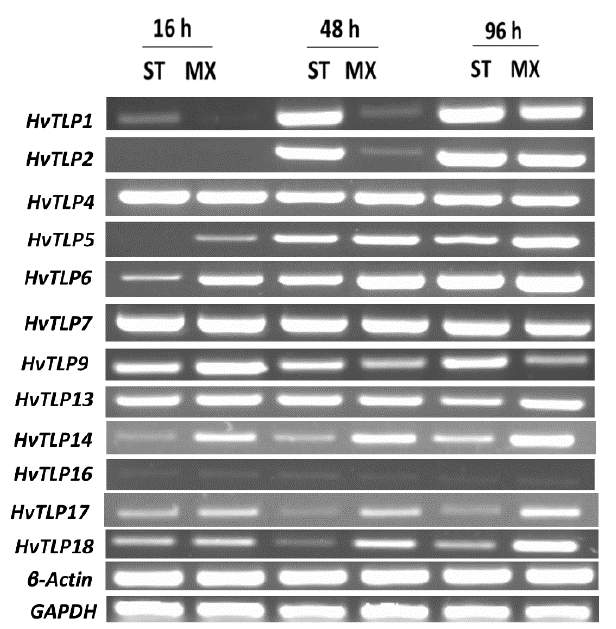
Figure 5. Transcript abundance of HvTLP genes at different stages of seed germination . Gel representation of the expression profiles of HvTLPs ( 1 , 2 , 4 , 5 , 6 , 7 , 9 , 13 , 14 , 16 , 17 and 18 ) and the housekeeping genes β -actin and GAPDH at 16 h, 48 h and 96 h of germination in malting (MX = Morex) and feed (ST = Steptoe) varieties of barley using RT-PCR. 1.2% agarose gel was used to resolve the amplified bands.